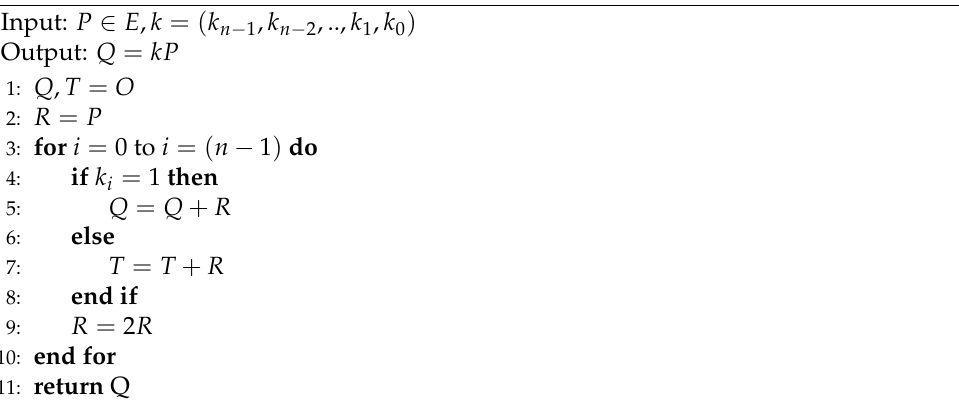
Algorithm 2 Double-and-Add-Always